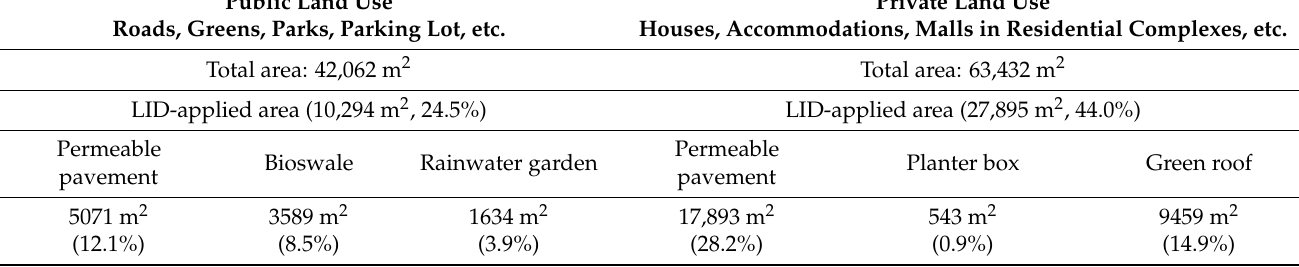
Table 11. Summary of simulation results.